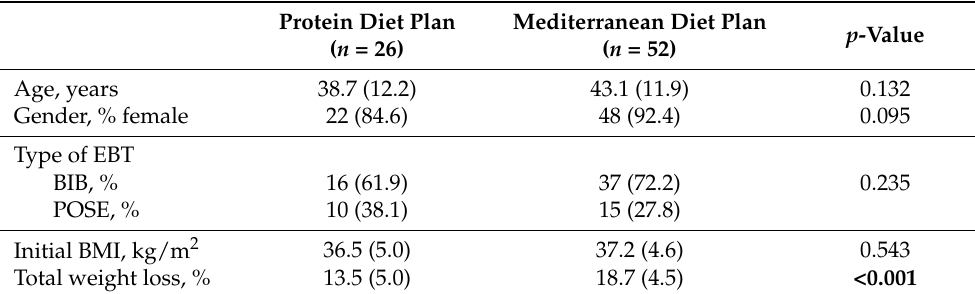
Table 1. General characteristics of the population